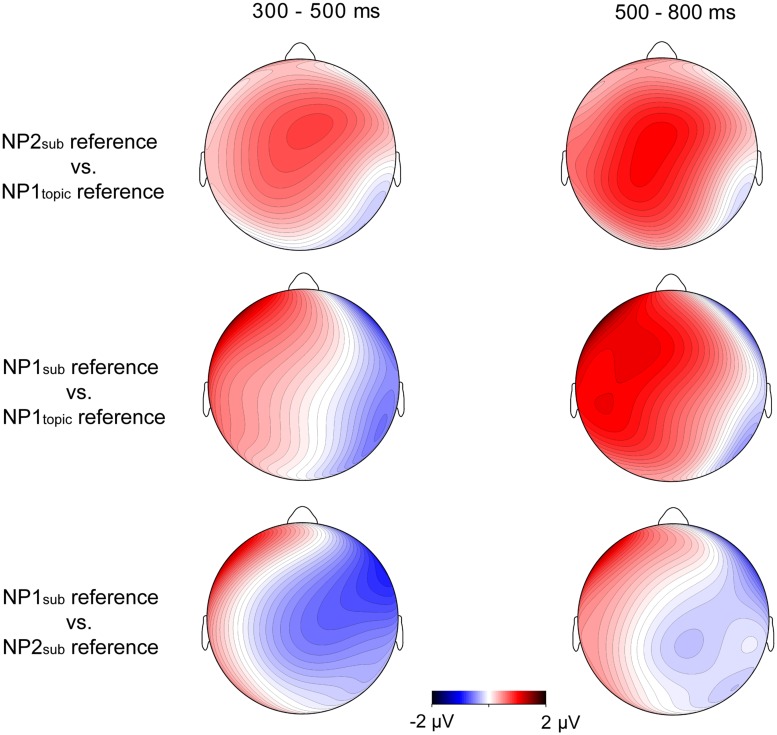
Topographic maps for difference waves on the pronoun in Experiment 2 between the NP2sub reference and the NP1topic reference, and between the NP1sub reference and the NP1topic reference, and between the NP1sub reference and the NP2sub reference in 300–500 ms window (left) and 500–800 ms window (right), respectively.